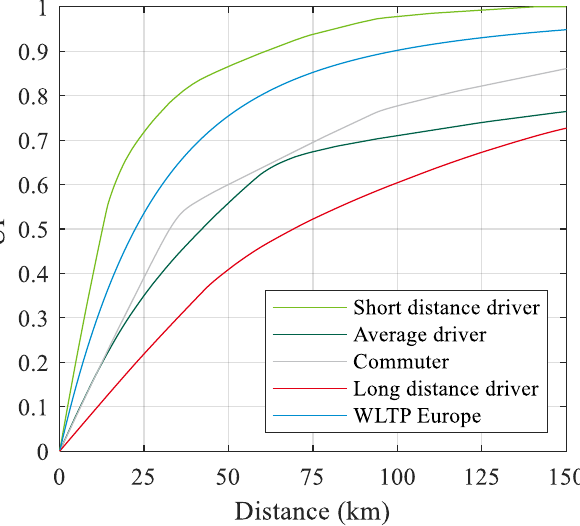
Figure 2. Comparison of ( a ) va pos and ( b ) RPA of the selected drivers to the fleet data.